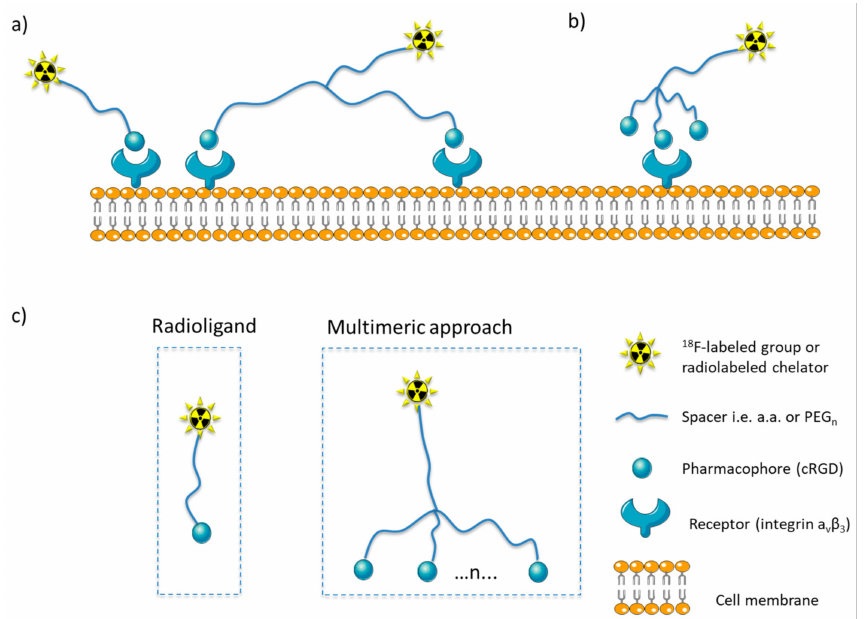
Figure 1. Binding models for multimers on the cell surface: ( a ) The binding of a radioligand to a cell surface receptors and the multimeric approach resulting in simultaneous binding of two pharmacophores connected via a long linker with two receptors, ( b ) improved binding efficiency of a ligand, due to the increased apparent local concentration of the pharmacophore (statistical effect) in the micro-environment of the receptor; ( c ) basic principles for the design of monomeric and multimeric radioligands (where n = number of